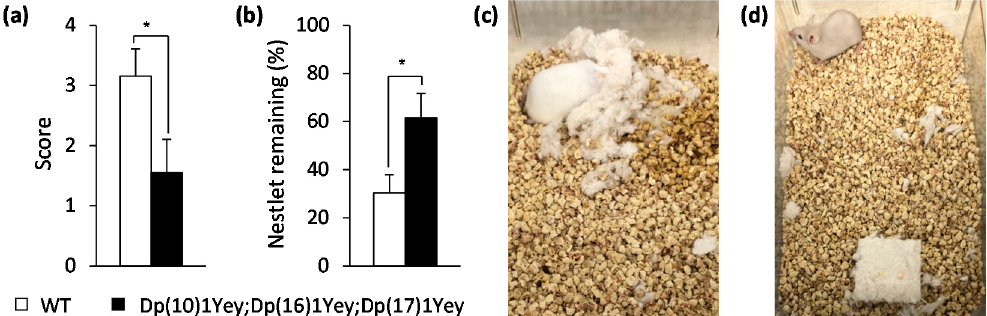
Figure 6. Nesting test: Dp(10)1Yey;Dp(16)1Yey;Dp(17)1Yey mice and the wild-type control mice were housed individually in a new cage with a pre-weighted Nestlet overnight. ( a ) The nest scores were 1.55 and 3.15 for the